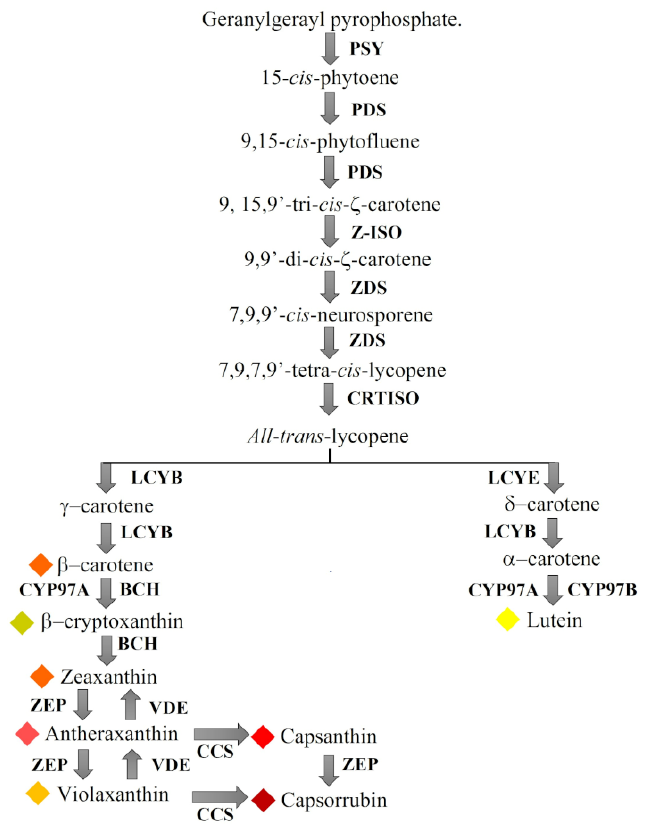
Figure 1. Chili pepper fruit carotenoid biosynthetic pathway. PSY (phytoene synthase), PDS (phytoene desaturase), Z-ISO ( ζ -carotene isomerase), ZDS ( ζ -carotene desaturase), CRTISO (carotene isomerase), LCYB ( β -lycopene cyclase), LCYE ( ε -lycopene cyclase), BCH ( β -carotene hydroxylase), CYP ( β -carotene hydroxylase cytochrome 450 types A and B), ZEP (zeaxanthin epoxidase), VDE (violaxanthin epoxidase), and CCS (capsanthin-capsorubin synthase). Modified from [1]. Colored rhombuses represent the color conferred by each carotenoid.